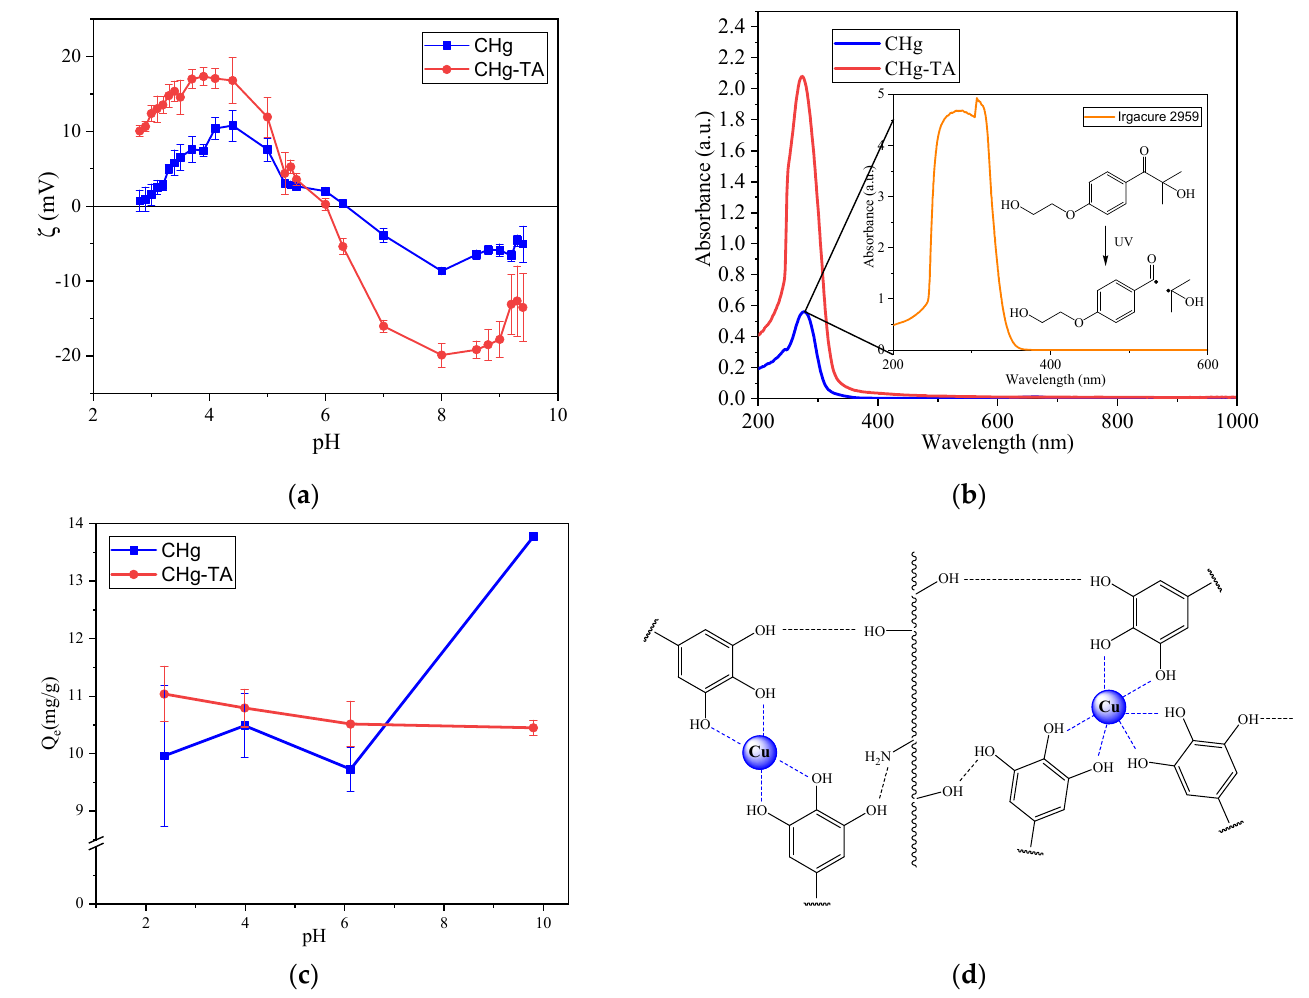
Figure 5. ( a ) ζ potential curves of CHg and CHg-TA; ( b ) UV-Vis spectra of pre-washing solutions and Irgacure 2959, with the mechanism of the benzoyl and alkyl radicals formation [76]; ( c ) the influence of pH on the Q e values of Cu 2+ ; ( d ) schematic representation of the adsorption mechanism of Cu 2+ into CHg-TA.